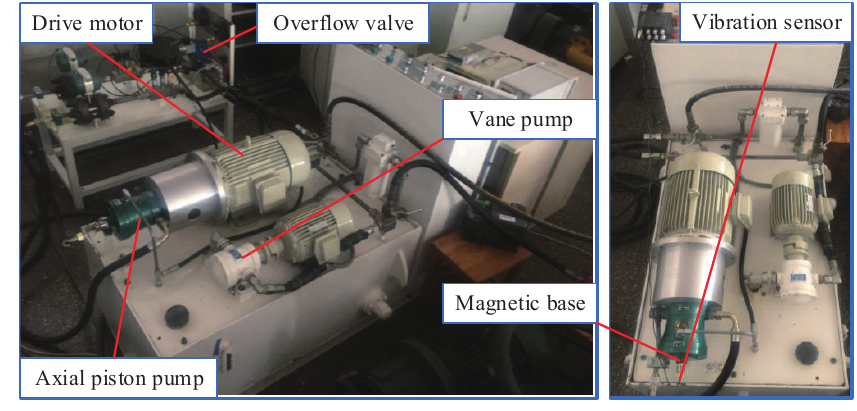
Figure 4. Test bench physical